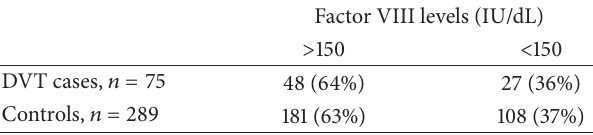
Table 1: Factor VIII distribution in cases and controls using 150 (IU/dL) as cut-off.